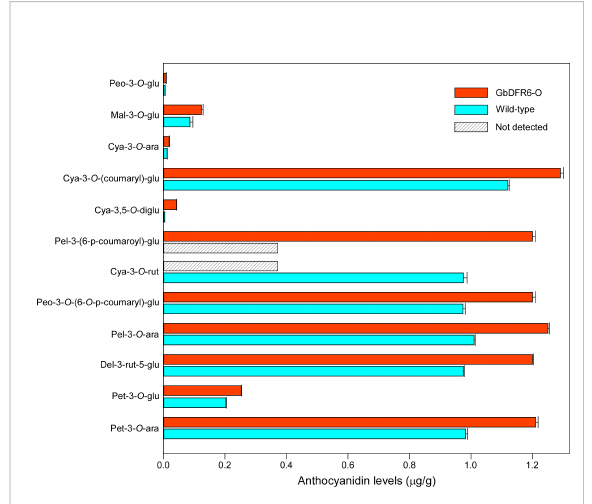
FIGURE 5 A comparison of various anthocyanin compounds between wild- type and transgenic tobacco leaves. A total of 12 anthocyanin compounds were detected. Pel-3- O -(coumaryl)-glu was not detected in wild-type tobacco leaves and cya-3- O -rut was not detected in transgenic tobacco leaves. Peo-3- O -glu, peonidin- 3- O -glucoside; Mal-3- O -glu, malvidin-3- O -glucoside; Cya-3- O -ara, Cya-3- O -(coumaryl)-glu, Cya-3,5- O -diglu, cyanidin-3,5- O -diglucoside; Pel-3-(6-p-coumaroyl)-glu, pelargonidin-3- O - (coumaryl)-glucoside; Cya-3- O -rut, cyaniding-3- O -rutinoside; Peo-3- O -(6- O -p-coumaryl)-glu, peonidin-3- O -(6- O -p- coumaryl)-glucoside; Pel-3- O -ara, pelargonidin-3- O - arabinoside; Del-3-rut-5-glu, delphinidin-3-rutinoside-5- glucoside; Pet-3- O -glu, petunidin-3- O -glucoside; Pet-3- O -ara, petunidin-3- O -arabinoside. Three biological repetitions were carried out during the